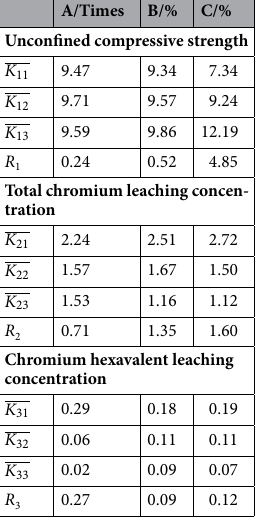
Table 2. Orthogonal test results range analysis calculation